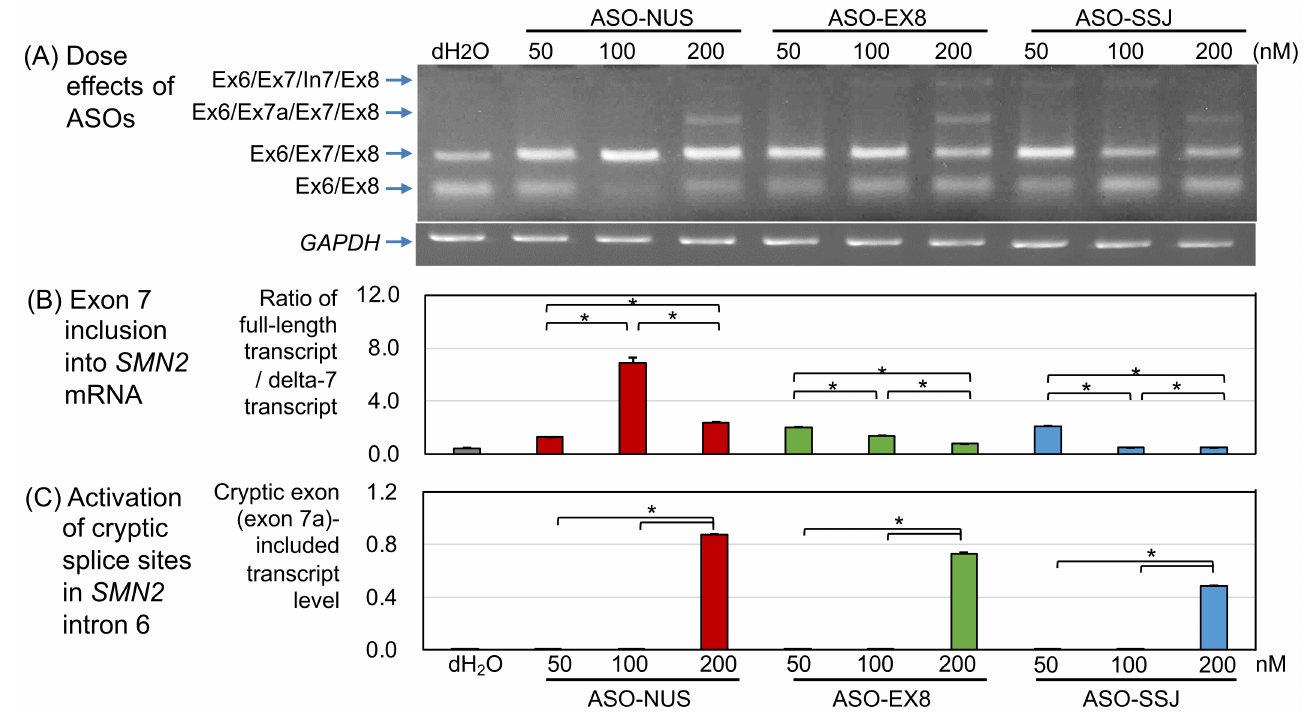
Figure 2. Dose effects of ASOs in spinal muscular atrophy (SMA) fibroblast. ( A ) Agarose gel electrophoresis of RT-PCR analysis. Lane 1 is control cells transfected with dH 2 O. The types and concentrations of ASOs used in this study are indicated here. The arrows indicate the transcript product of SMN2 (upper panel) or glyceraldehyde-3-phosphate dehydrogenase ( GAPDH ) (lower panel). ( B ) Quantification of exon 7 inclusion into SMN2 mRNA determined from the ratios of full-length transcript/delta-7 transcript (RFD). ( C ) Quantification of exon 7a into SMN2 mRNA. An asterisk (*) indicates p < 0.01 in ANOVA.